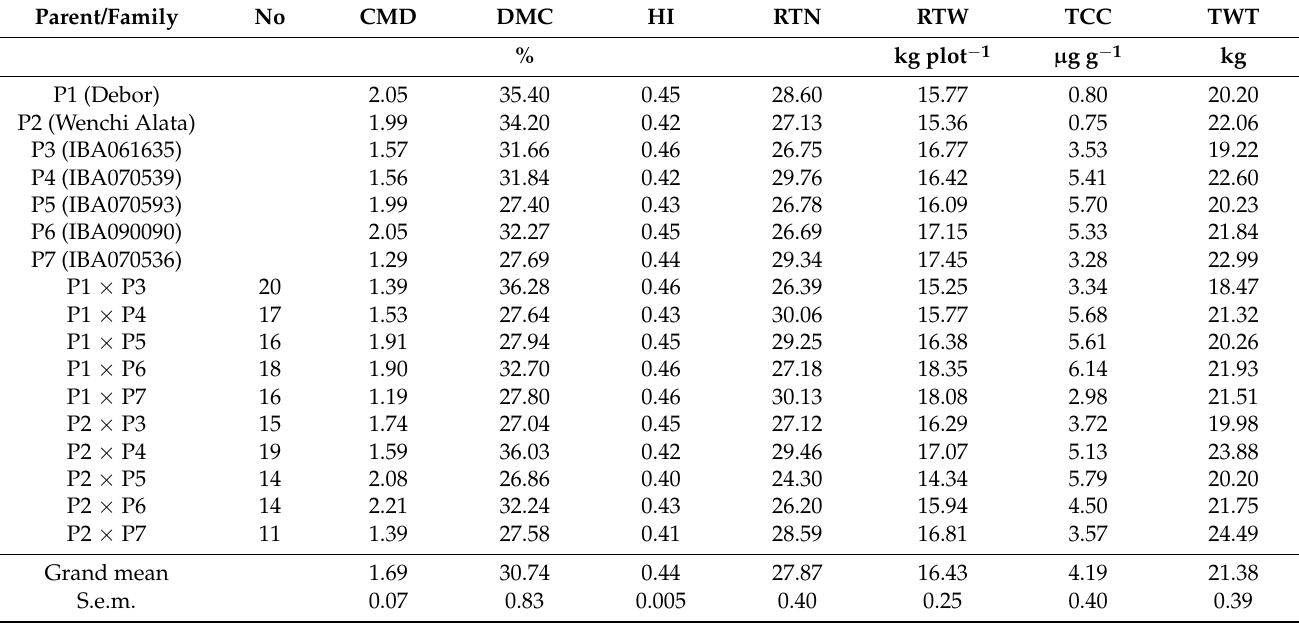
Grand mean CMD, Cassava mosaic disease; DMC, Dry matter content; HI, Harvest index; RTN, Storage root number; RTW, Storage root weight; TCC, Total carotenoid content; TWT, Total biomass; s.e.m., standard error of means.